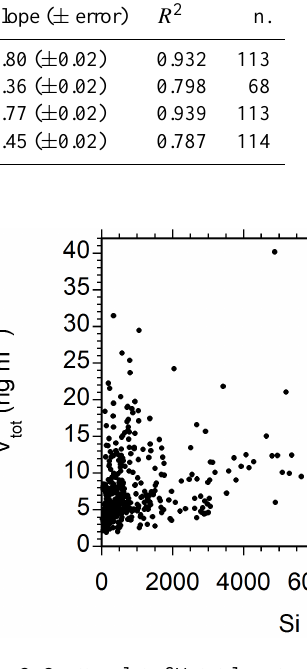
Fig. 2. Scatter plot of V total content obtained by PIXE versus